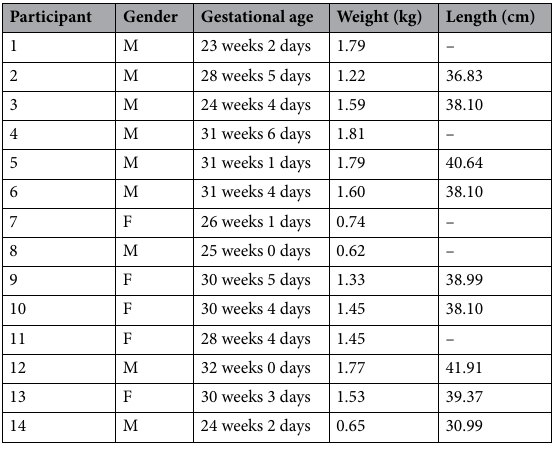
Table 1. Participant characteristics at birth. A (−) indicates no data for